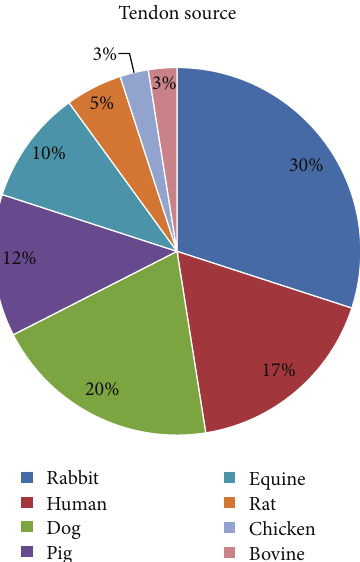
Figure 3: Tendon sources. The pie chart shows the relative distri- bution of species from which tendons have been harvested to be